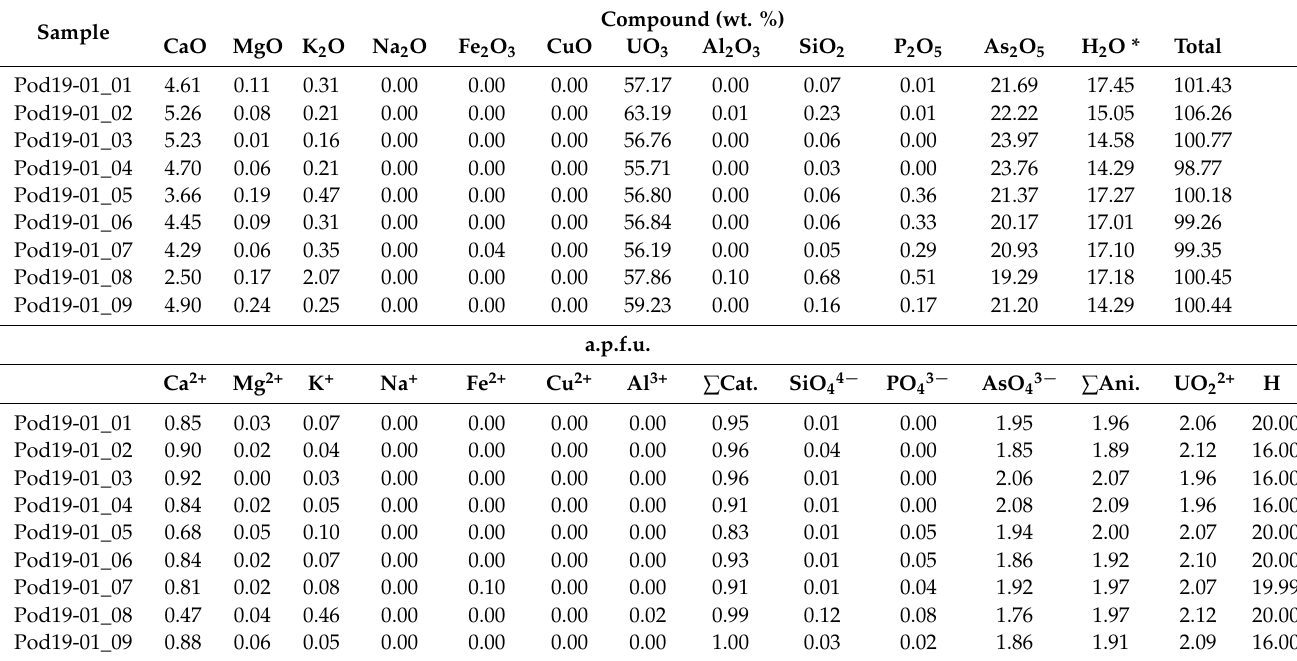
Figure 4. Uranyl arsenates from Podg ó rze mine: ( A ) uranospinite, ( B ) nov á ˇcekite-II, ( C ) natroura- nospinite, and ( D ) EDS spectrum of natrouranospinite. Table 2. Chemical composition of uranospinite by